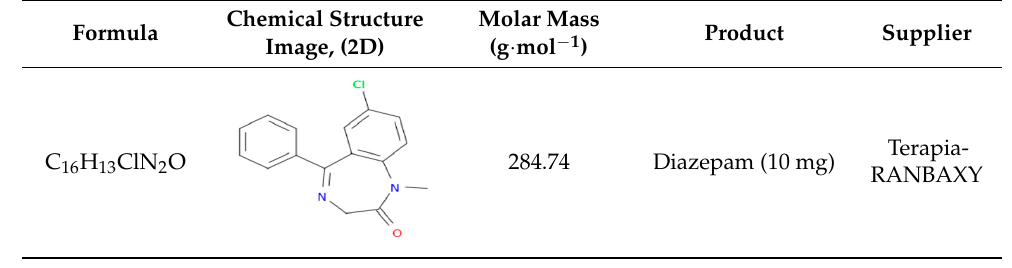
Table 1. Characteristics of drug molecule.